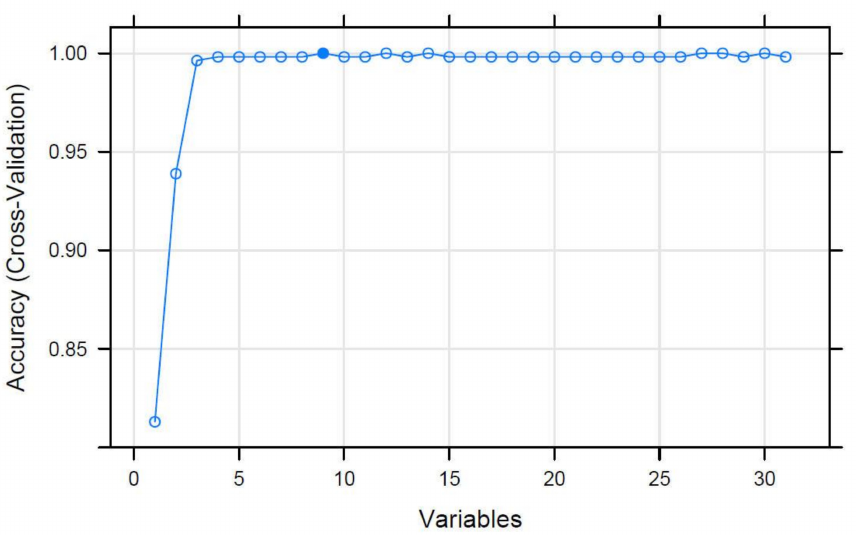
Figure 8. Resampling results for the candidate subset sizes.